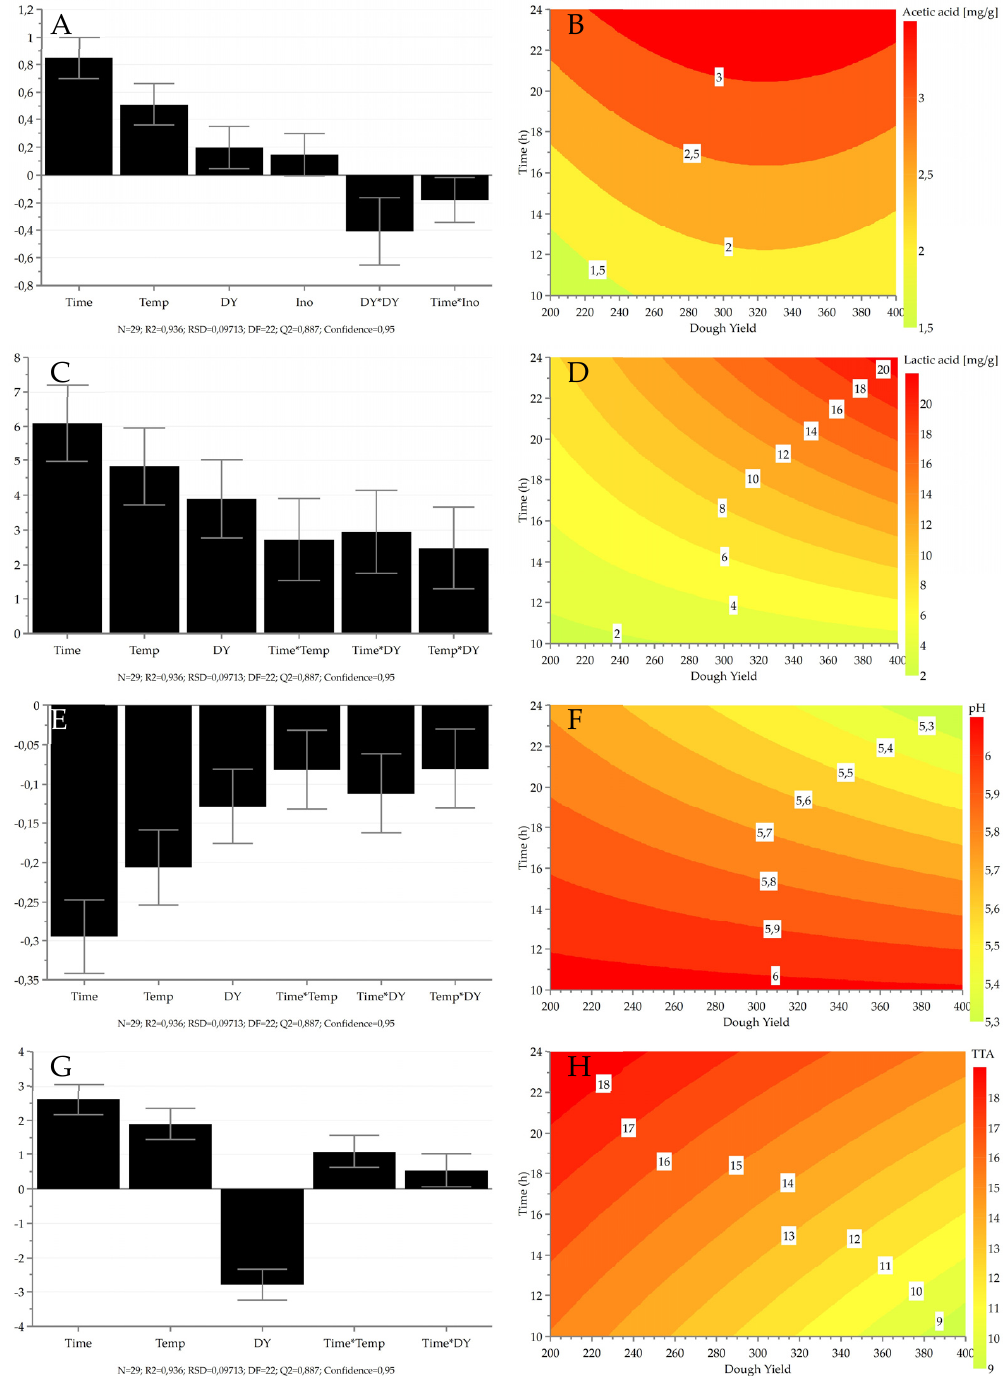
Figure 4. Coefficient plots showing the regression coefficients for the measured responses of acetic acid ( A ), lactic acid ( C ), pH ( E ), and total titratable acidity ( G ). Bars indicate the variation in response when a factor changes from 0 to high. The higher the bar, the stronger the effect of the variable on the indicated response. Positive and negative bars indicate a positive and negative effect, respectively. Error bars indicate the 95% confidence interval. Response surface plots as a function of dough yield and time for acetic acid ( B ), lactic acid ( D ), pH ( F ), and total titratable acidity ( H ). Temperature and inoculum ratio were left constant at 25 °C and 6 log CFU/g, respectively. Temp—temperature; DY—dough yield; Ino—inoculum ratio; N—number of observations; R2—explained variation; RSD—residual standard deviation; DF—degrees of freedom; Q2—predicted variation.